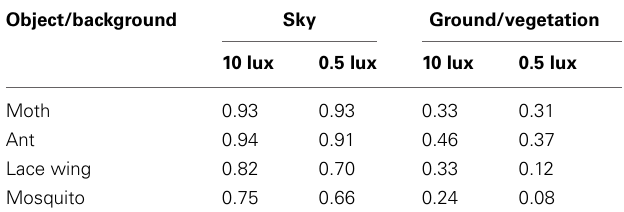
different light